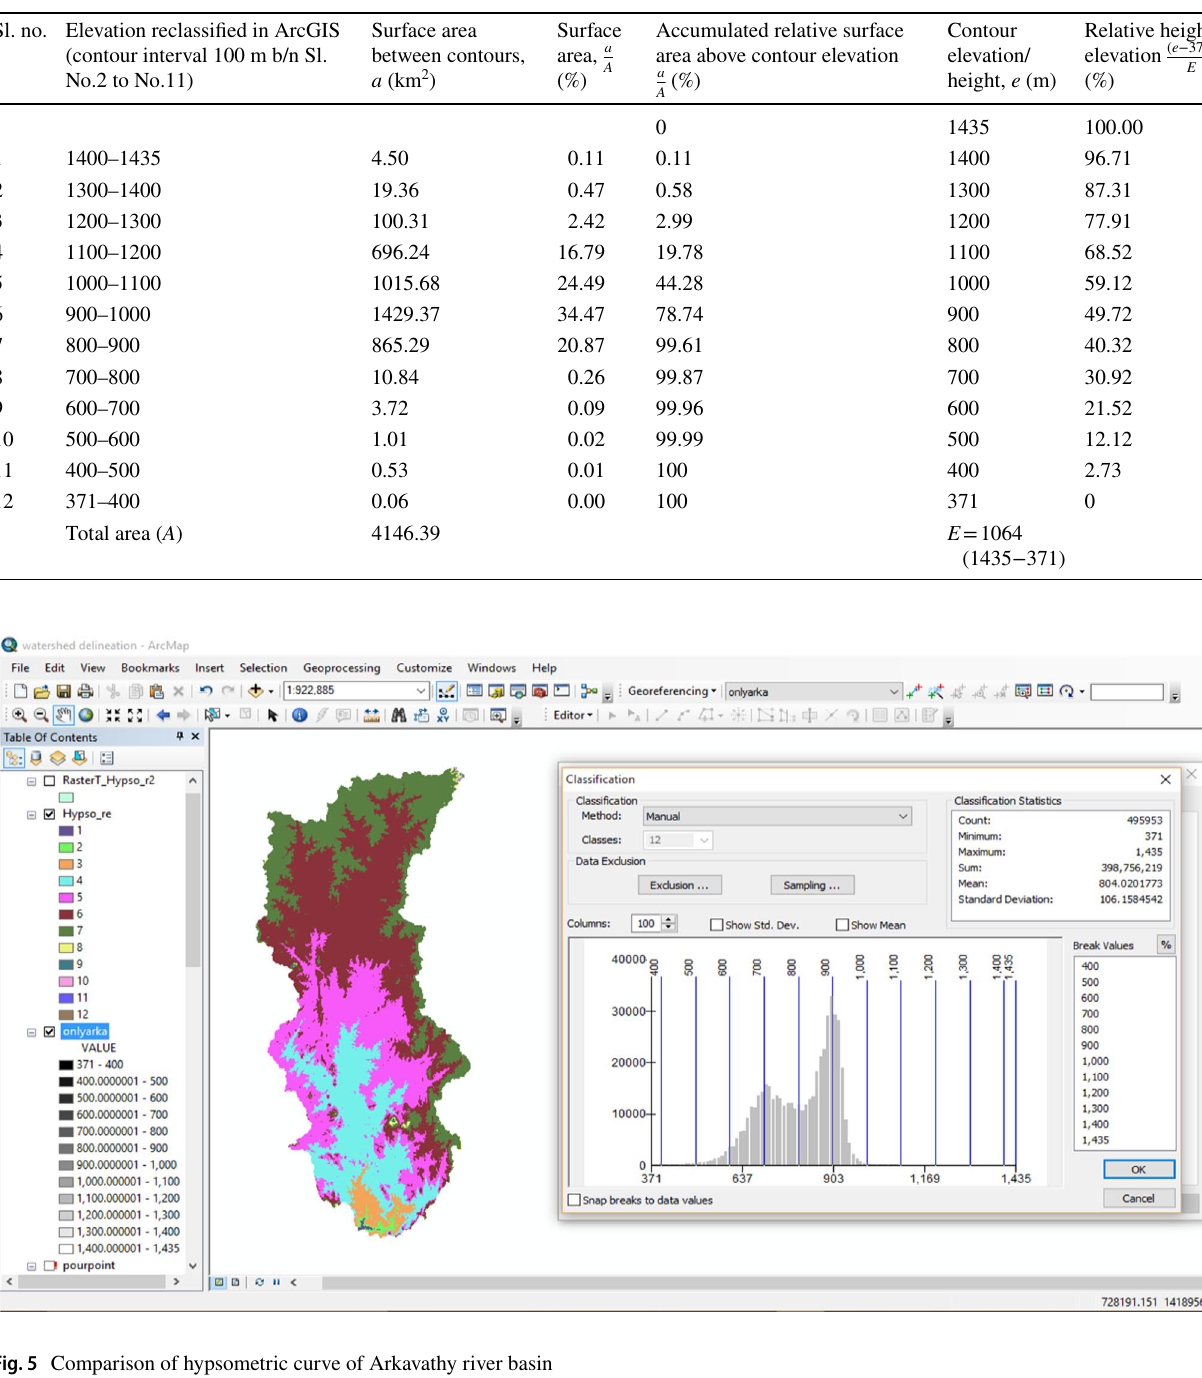
Fig. 5 Comparison of hypsometric curve of Arkavathy river